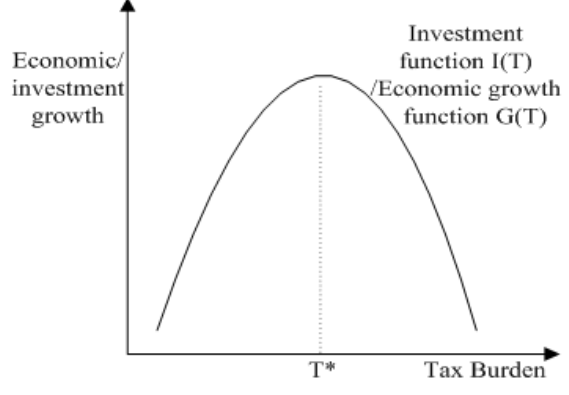
Figure 1. Economic (Investment) growth and Macro tax